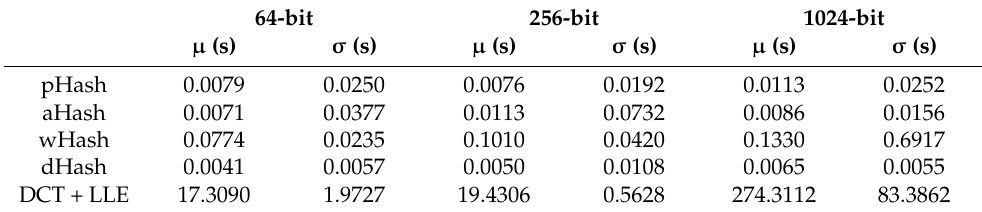
Table 3. Distribution of computational times for Step 4.